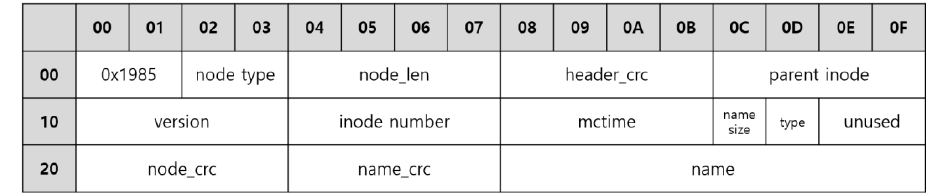
Figure 12. JFFS2 dirent node in form of hex value.